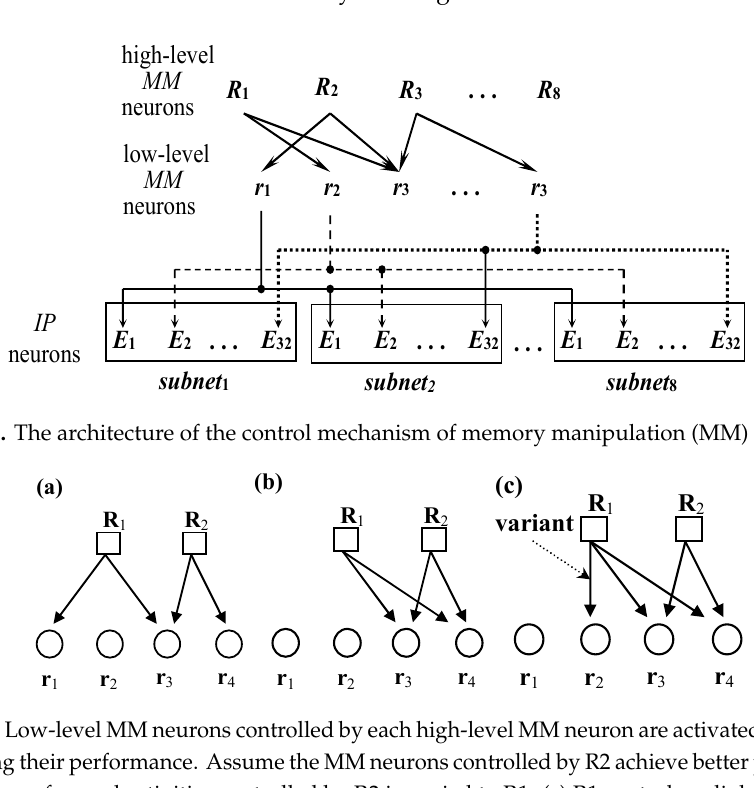
Figure 3. Evolutionary learning at the IP neuron level.